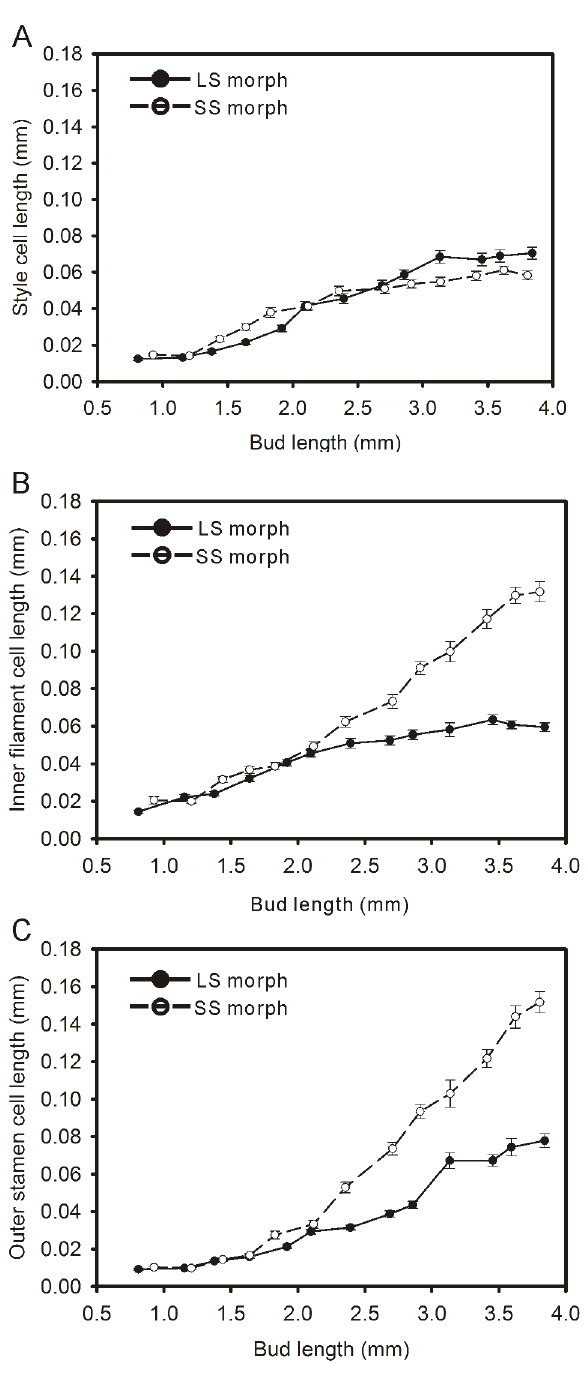
Figure 6. The lengths of epidermal cells in styles or filaments during floral development of Polygonumjucundum . A, Style; B, Inner filament; C, Outer filament. Trend lines were plotted separately for the data for each floral morph. Error bars indicate the range in epidermal cell lengths. doi:10.1371/journal.pone.0102802.g006 anther height in two morphs. The different gynoecium growth in both morphs was affected by both cellular fission and extension [16]. However, in P. jucundum , during style growth, cell elongation in LS morph was similar to that in SS morph, but cell division in LS morph was greater than in SS morph. This